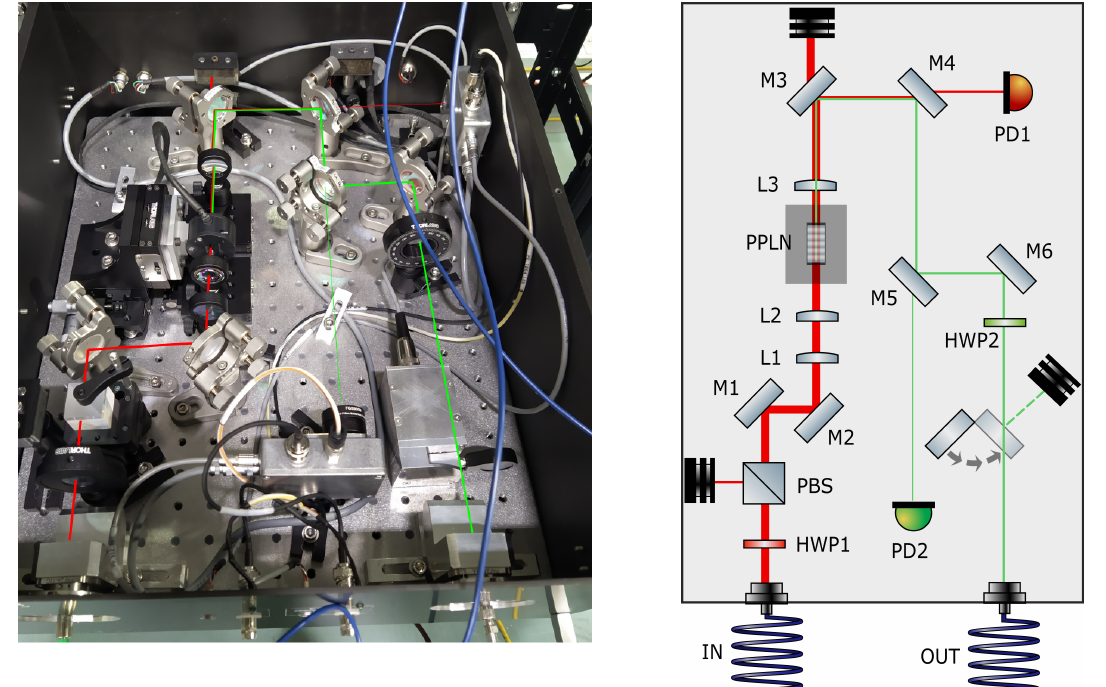
Figure 6. Second Harmonic Generation (SHG) bench. On the left, a picture of one of the three frequency-doubling setups realized in EGO, on the right, an optical scheme of the setup. The Polarized Beam Splitter (PBS) and the Half-Wave Plate (HWP) ensure the correct polarization and allow one to tune the power. The lenses L1 and L2 form a telescope to focus the beam into the crystal and the lense L3 collimates it at the output. M3, M4, and M5 are dichroic mirrors, transmittive for the infrared and reflective for the green. With M5 and M6 the beam is coupled into the fiber and the HWP2 adjusts its polarization to the axis of the output fiber. PD1 and PD2 are monitoring photodiodes for the infrared and the green powers